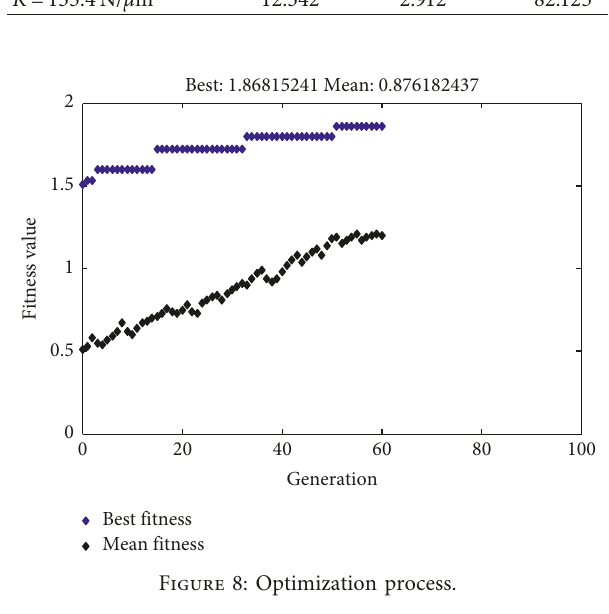
Figure 8: Optimization process.